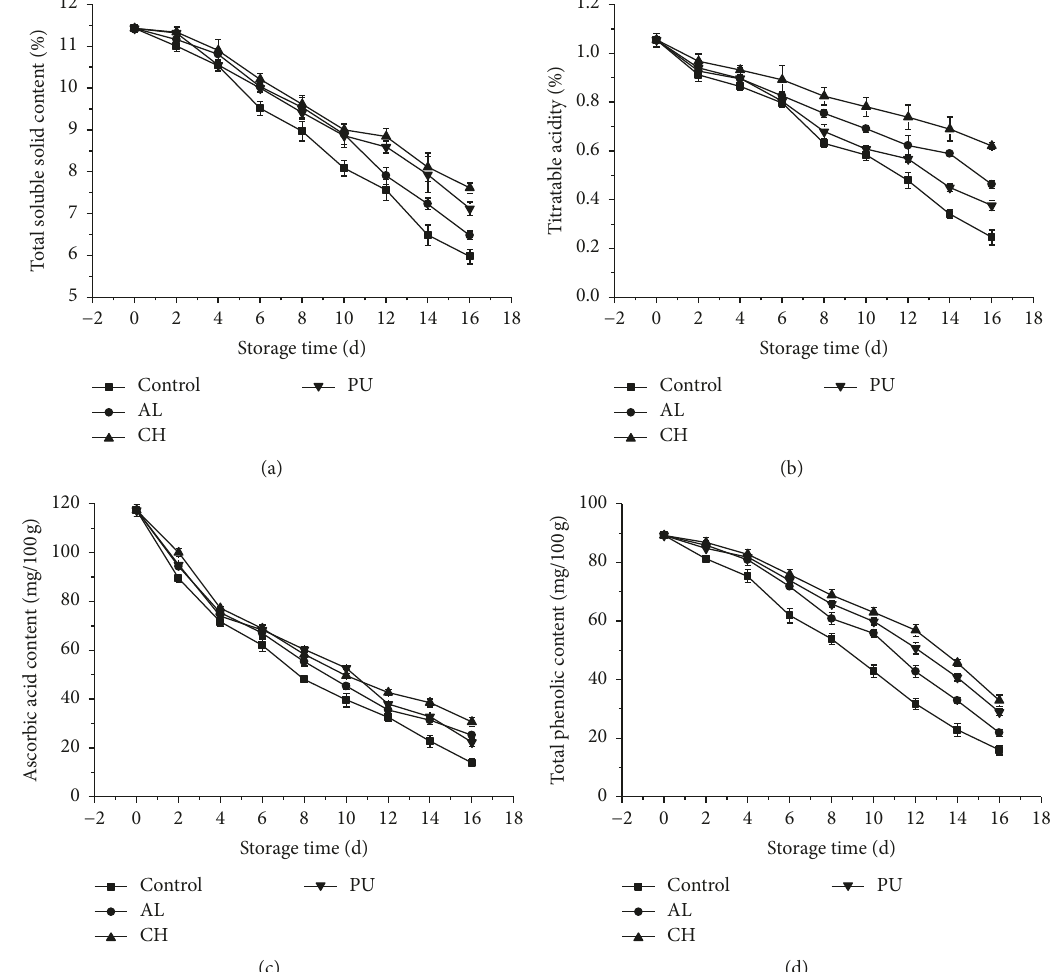
Figure 2: Effects of three different polysaccharide-based edible coatings on TSS (a), TA (b), VC (c), and TP (d) contents of strawberry.